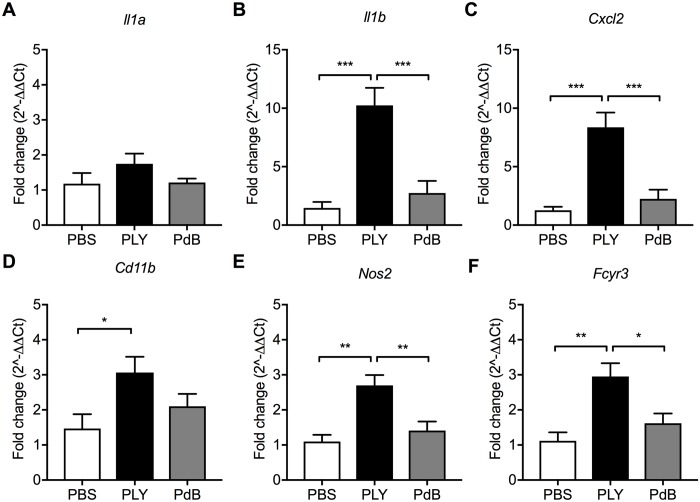
Pneumolysin pore-formation drives host responses.Pups colonized with the serotype 4 ply- received daily treatments with 100 ng recombinant Ply (PLY) or toxoid PdB (W433F) starting at 24 hours until 4 days after inoculation. Control animals received PBS dosing. The URT of the pups was lavaged to obtain RNA for qRT-PCR analysis at 5 days post-challenge. Fold change in expression of (A) Il1a, (B) Ilb, (C), Cxcl2, (D) Cd11b, (E) Nos2, and (F) Fcγr3 was calculated compared to PBS-treated control pups. Groups represent n = 7–11 animals with mean ±SEM. Significance is indicated by *, P < 0.05; **, P < 0.01; ***, P < 0.001.